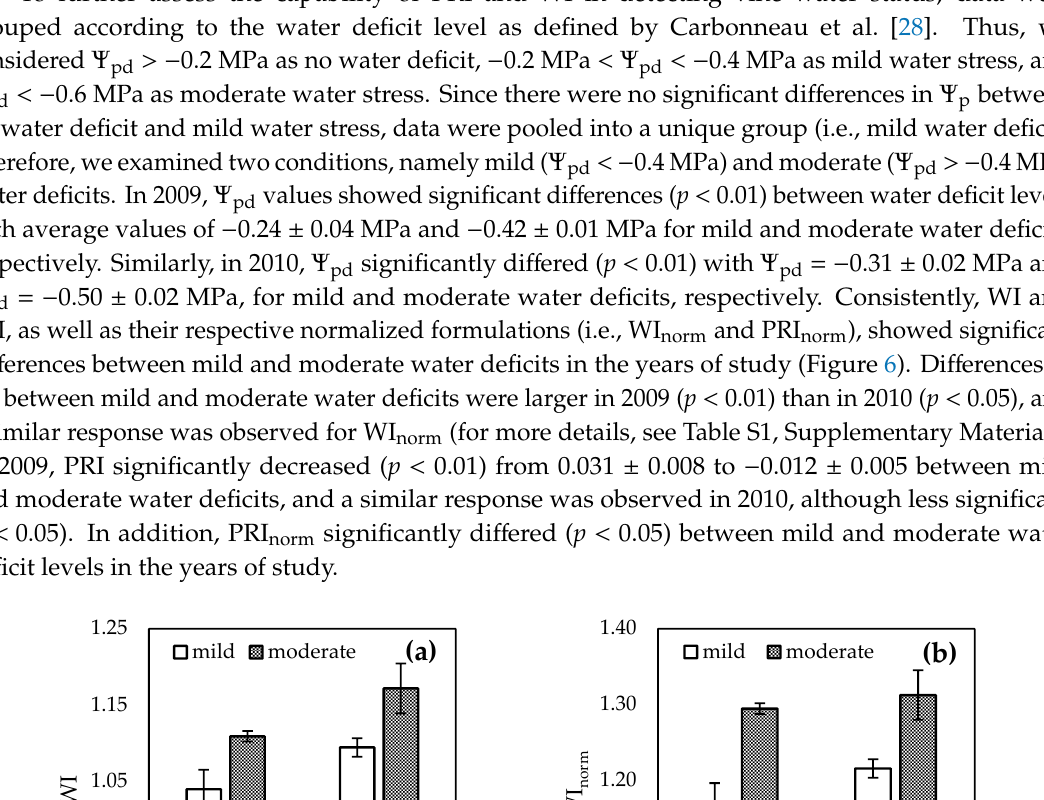
Figure 5. Relationships between predawn water potential ( Ψ pd ) and the reflectance indices ( a ) water index (WI), ( b ) normalized water index (WI norm ), ( c ) photochemical reflectance index (PRI), and ( d ) normalized photochemical reflectance index (PRI norm ) in Xarel·lo vines. Pooled data for 2009 ( n = 14) and 2010 ( n = 12).